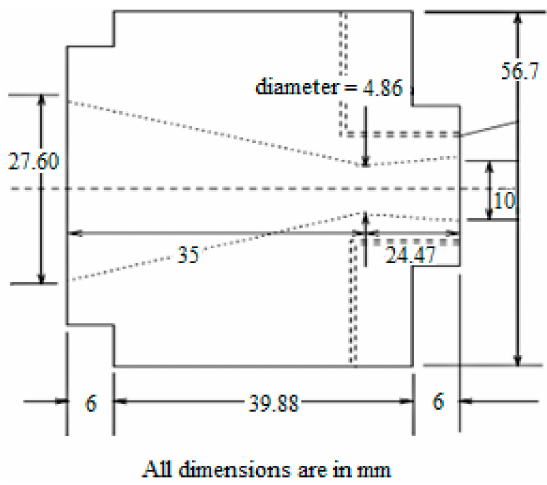
Figure 2. Mach 3.0 nozzle